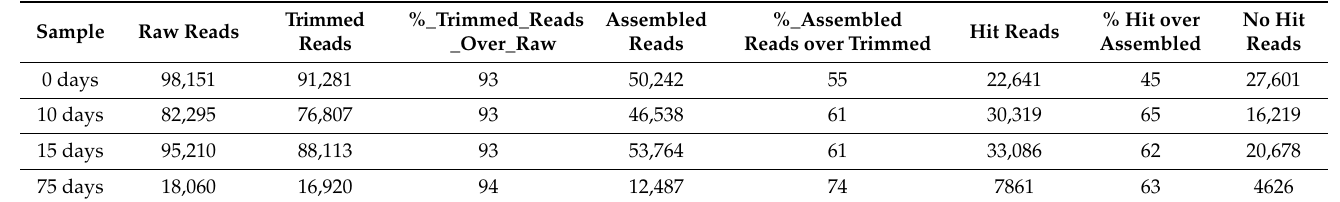
Table 2. Sequencing read processing results. Sequencing and alignment metrics for the four selected sequenced samples are reported, from the number of initial raw reads to the number of reads not aligned to the reference NCBI 16S RefSeq database.